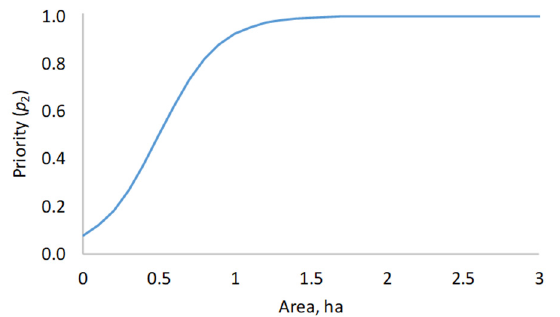
Figure 4. A sub-priority function for segment